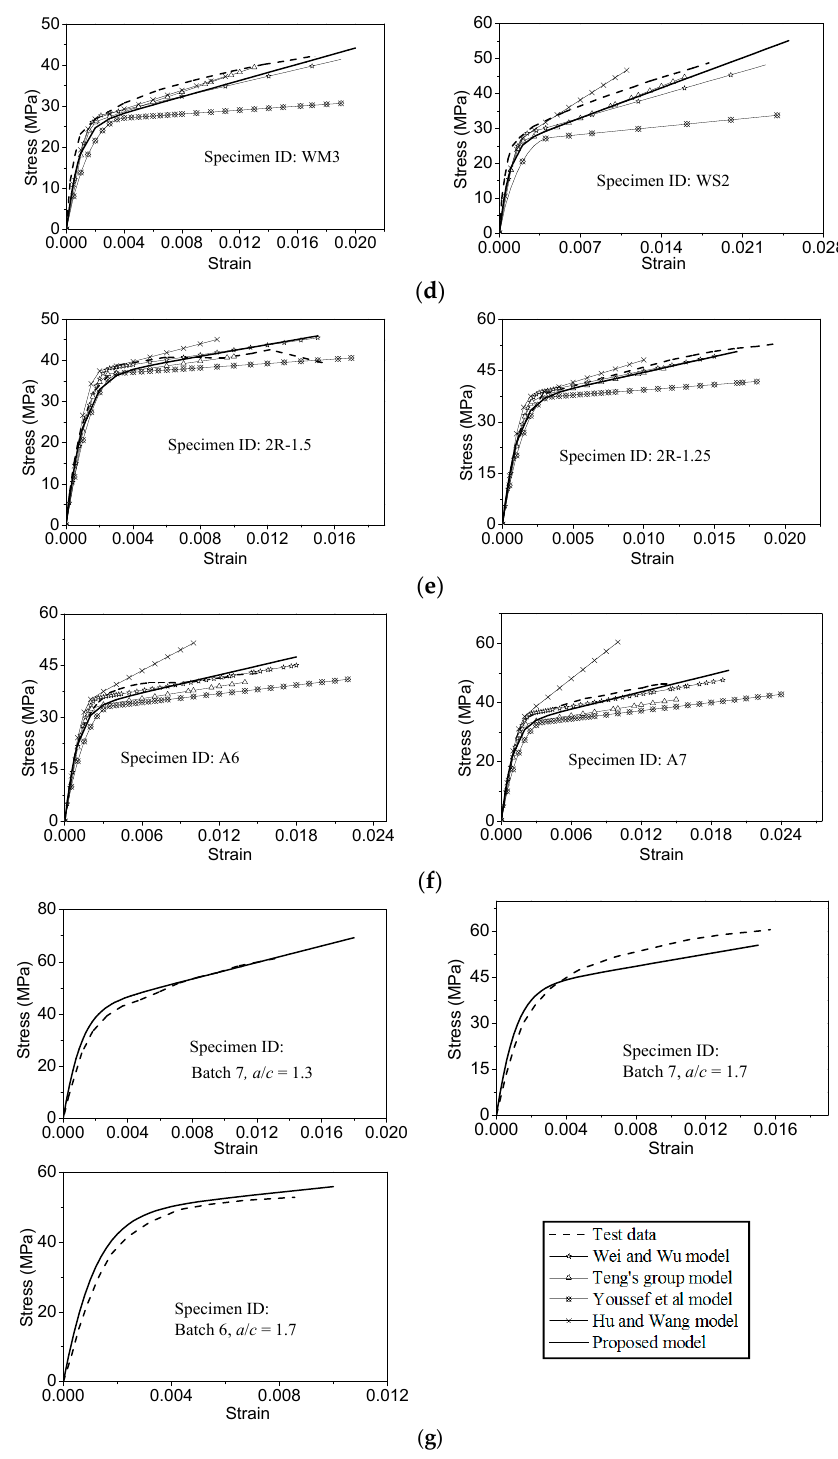
Figure 12. The performance of the proposed model for different cross-sectional columns. ( a ) Test results from Lam and Teng for circular columns [37]; ( b ) test results from Xiao and Wu for circular columns [35]; ( c ) test results from Wang and Wu for square columns [62]; ( d ) test results from Masia et al. for square columns [46]; ( e ) test results from Wu and Wei for rectangular columns [63]; ( f ) test results from Abbasnia and Ziaadiny for rectangular columns [50]; ( g ) test results from Stefano for elliptical columns [39].